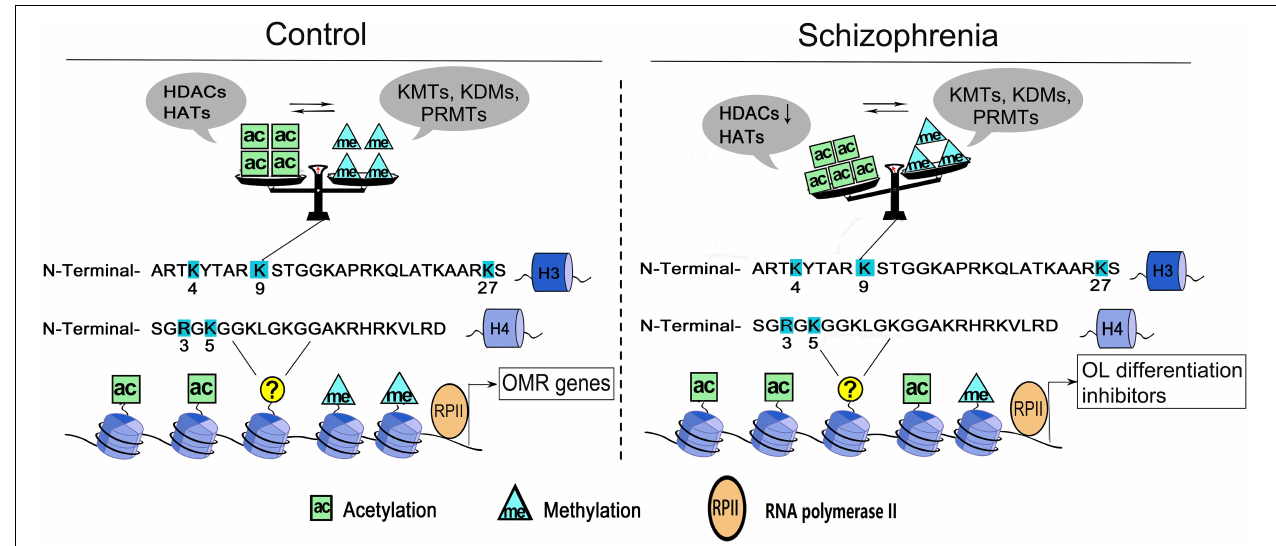
FIGURE 1 | A working model of histone acetylation and methylation underlying OLs dysfunction in schizophrenia. Histone acetylation and methylation at the promoters governing the expression of oligodendrocyte/myelin-related (OMR) genes. Multiple sites of H3 and H4 are dynamically regulated by histone acetyltransferases/deacetylases (e.g., HATs, HDACs) and/or histone methyltransferases/demethylases (e.g., KMTs, KDMs, and PRMTs). The cross-talk between two classes of enzymes secures the balance of epigenetic marks in OLs. In schizophrenia, the dysregulation of enzymes could change the balance/priority of histone acetylation and methylation at some key sites (e.g., H3K9), thus induce the reactivation of OL differentiation inhibitors and increase the cellular susceptibility. ac, histone acetylation; me, histone methylation; H3, histone 3; H4, histone